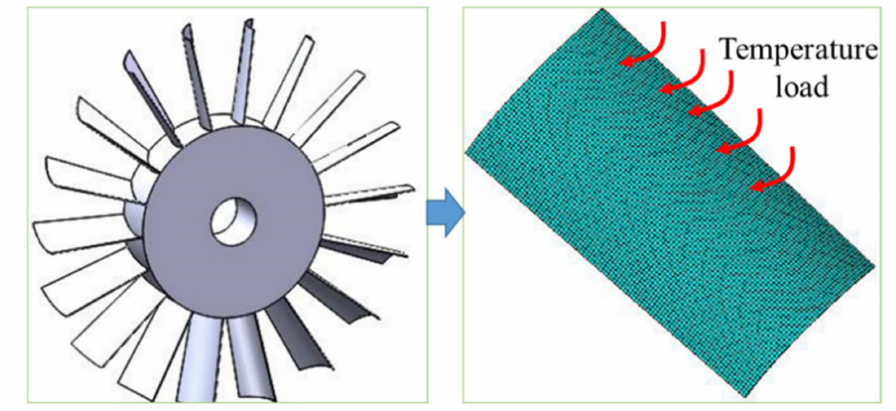
Figure 8. The finite element model of the single blade